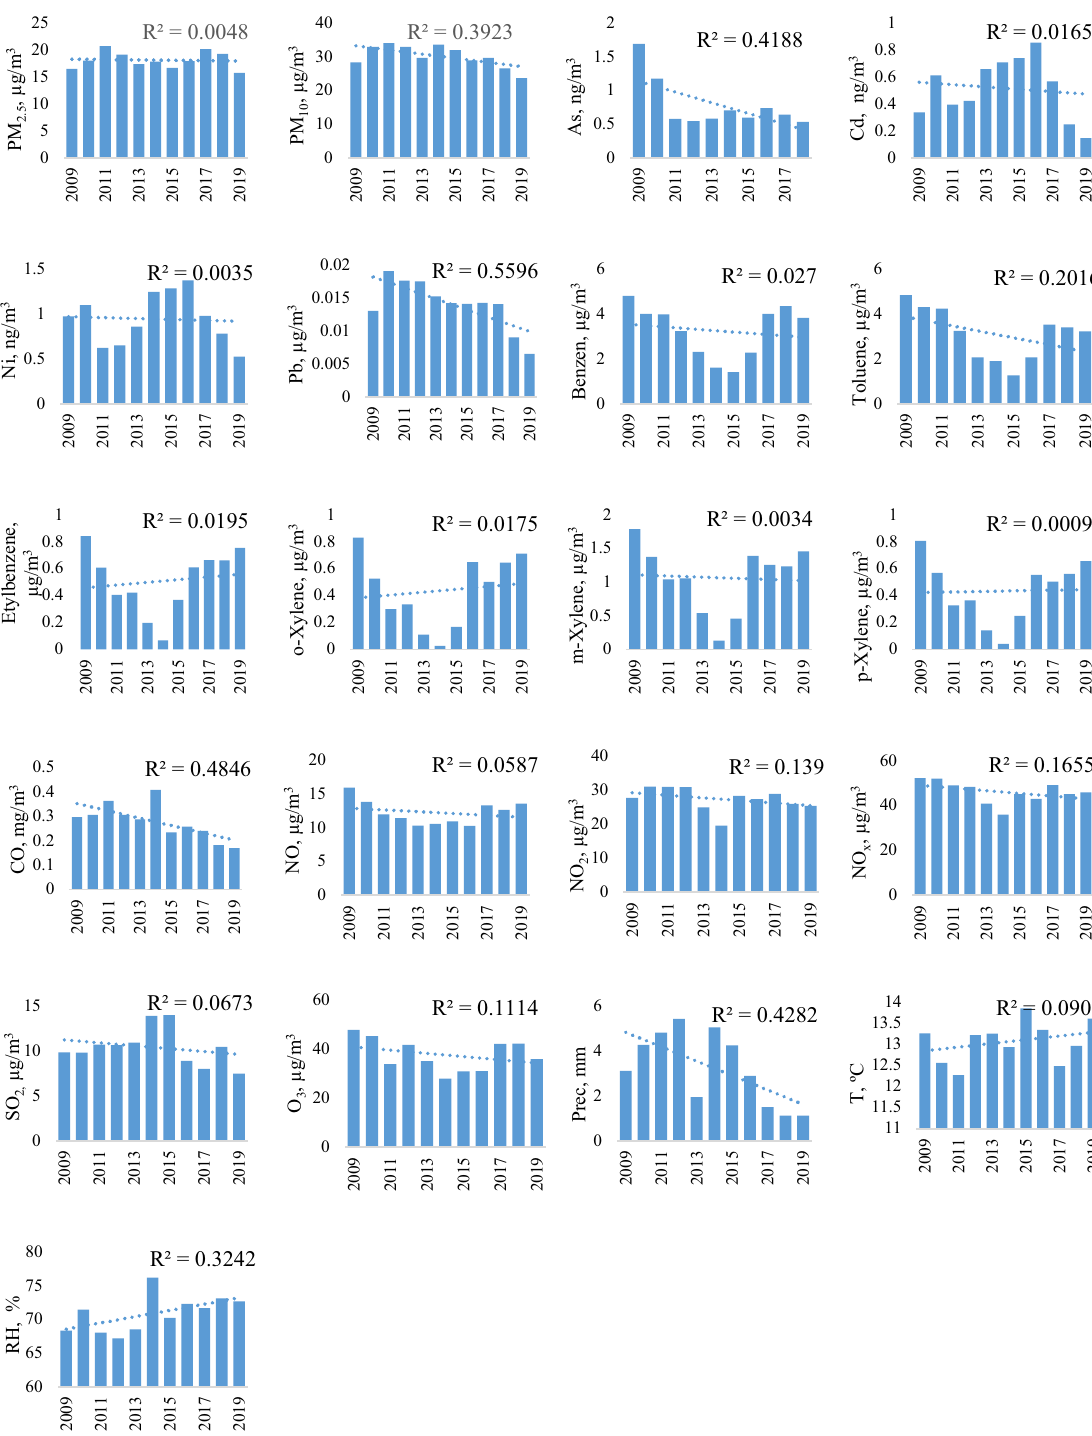
Figure 2. The annual variation of mean concentrations of air pollutants and environmental parameters. Where the dotted lines are trend